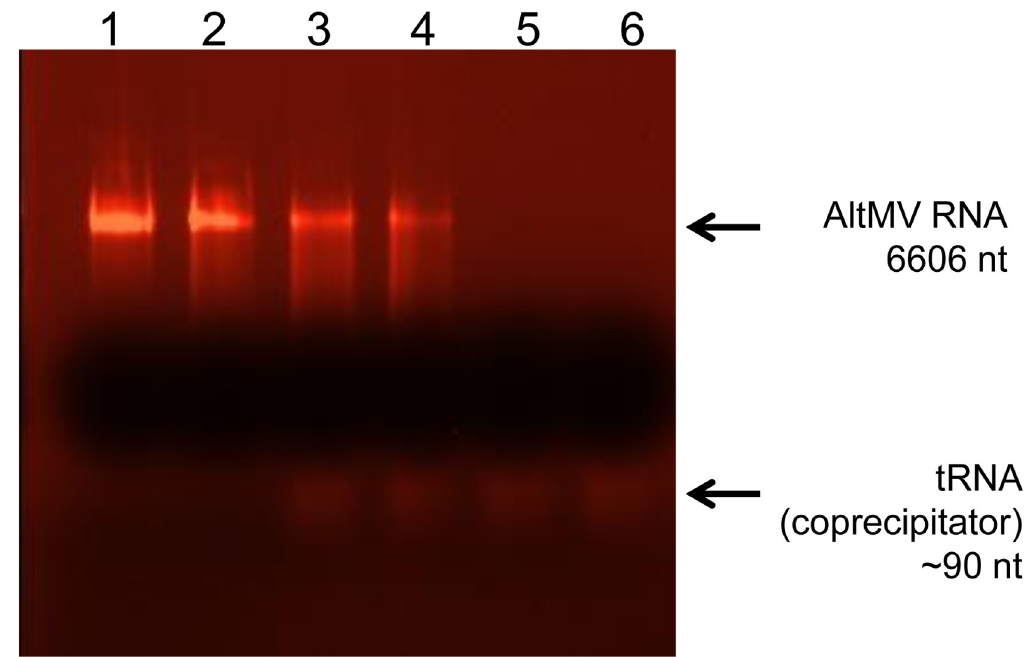
Fig 3. Characterisation of the RNA state within the AltMV SP V . 1) AltMV RNA (positive control)– 6606 nt; 2) RNA isolated from AltMV virions (sample 4); 3) RNA isolated from non-centrifuged AltMV SP V (sample 3); 4) RNA isolated from supernatant after SP V low-speed centrifugation (sample 2); 5) RNA isolated from SP V pellet after low-speed centrifugation (sample1); 6) negative control (Milli-Q water passed through all procedures similar to samples). Virions were heated to 98˚C for 30 sec. Electrophoretic analysis in 1% agarose gel. The gel was stained with ethidium bromide.